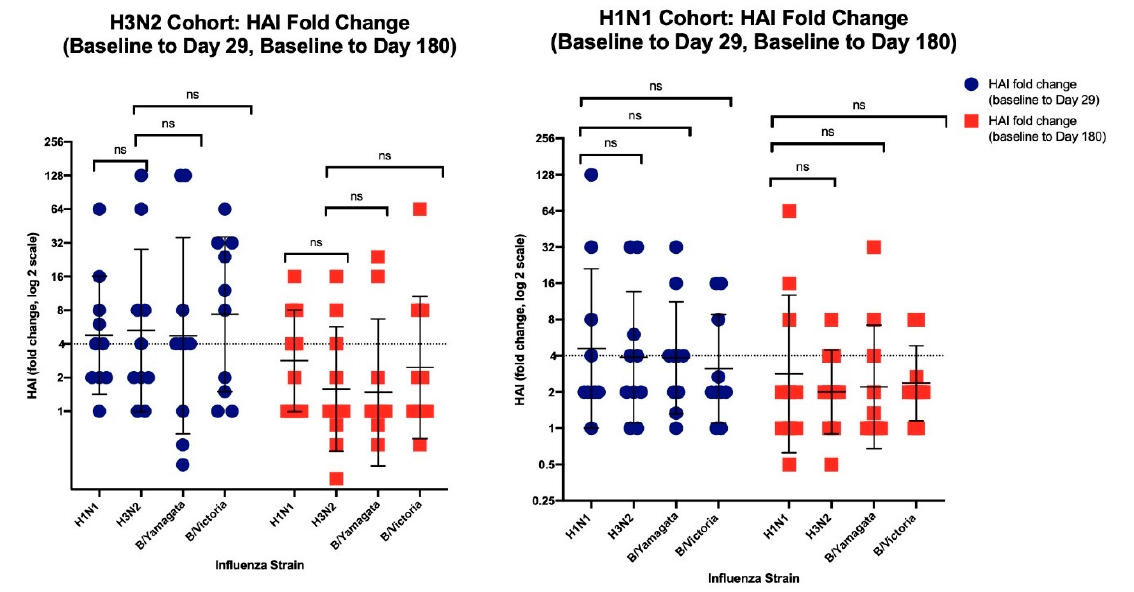
Figure 2. The left panel shows the H3N2 birth cohort and the right panel shows the H1N1 birth cohort. Blue dots are the HAI fold-change from baseline to Day 29, and red squares are the HAI fold-change from baseline to Day 180. The horizontal dotted line at 4 represents the fold change magnitude associated with seroconversion. The error bars denote geometric mean and geometric mean standard deviation, and “ns” denotes a non-significant difference.